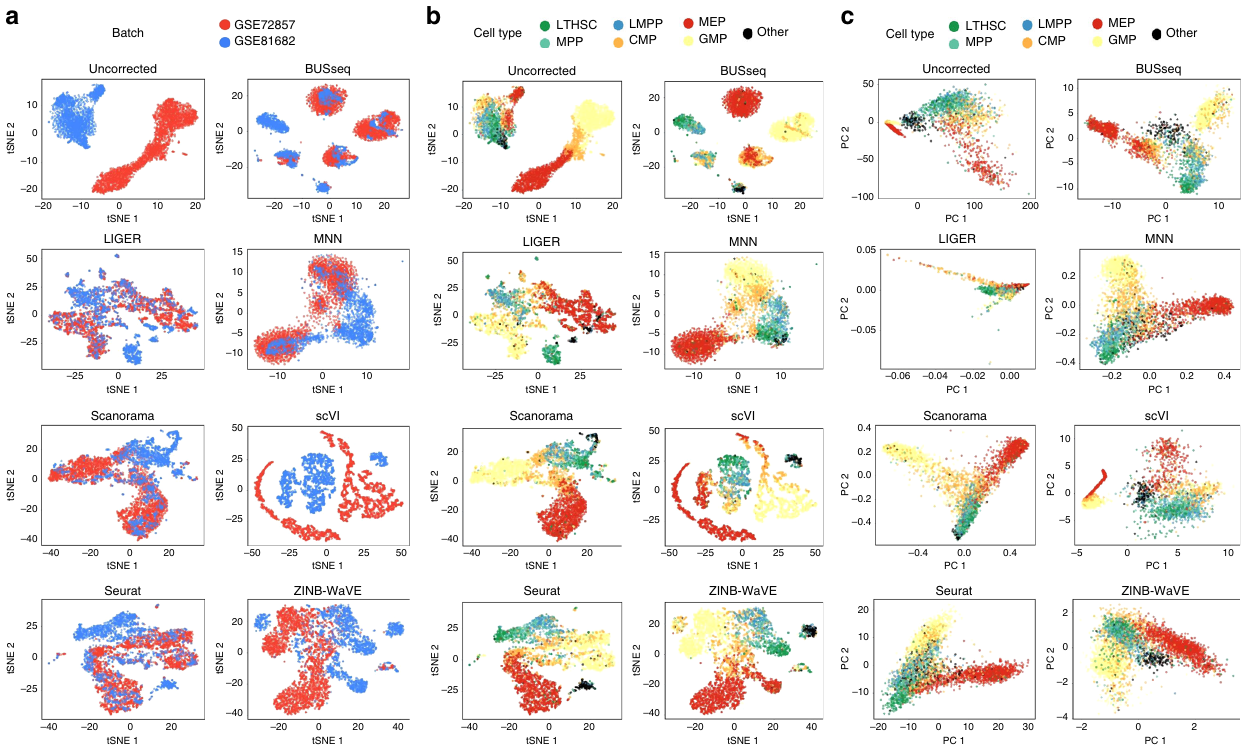
Fig. 4 t-SNE and Principal Component Analysis (PCA) plots for the hematopoietic data. a t-SNE plots colored by batch. b t-SNE plots colored by FACS cell type labels. c PCA plots colored by FACS cell type labels. BUSseq adjusts batch effects and correctly clusters cells according to their FACS cell type labels in the hematopoietic study.